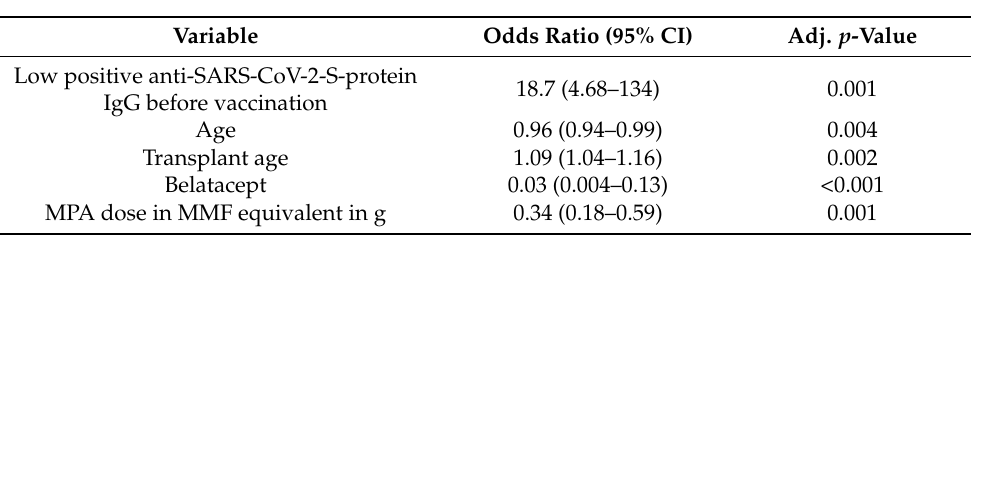
Table 4. Predictors of serological response after four doses of SARS-CoV-2 vaccines identified in mul- tivariable analysis. Adjusted (adj.) p -value according to Holm’s correction for multiple